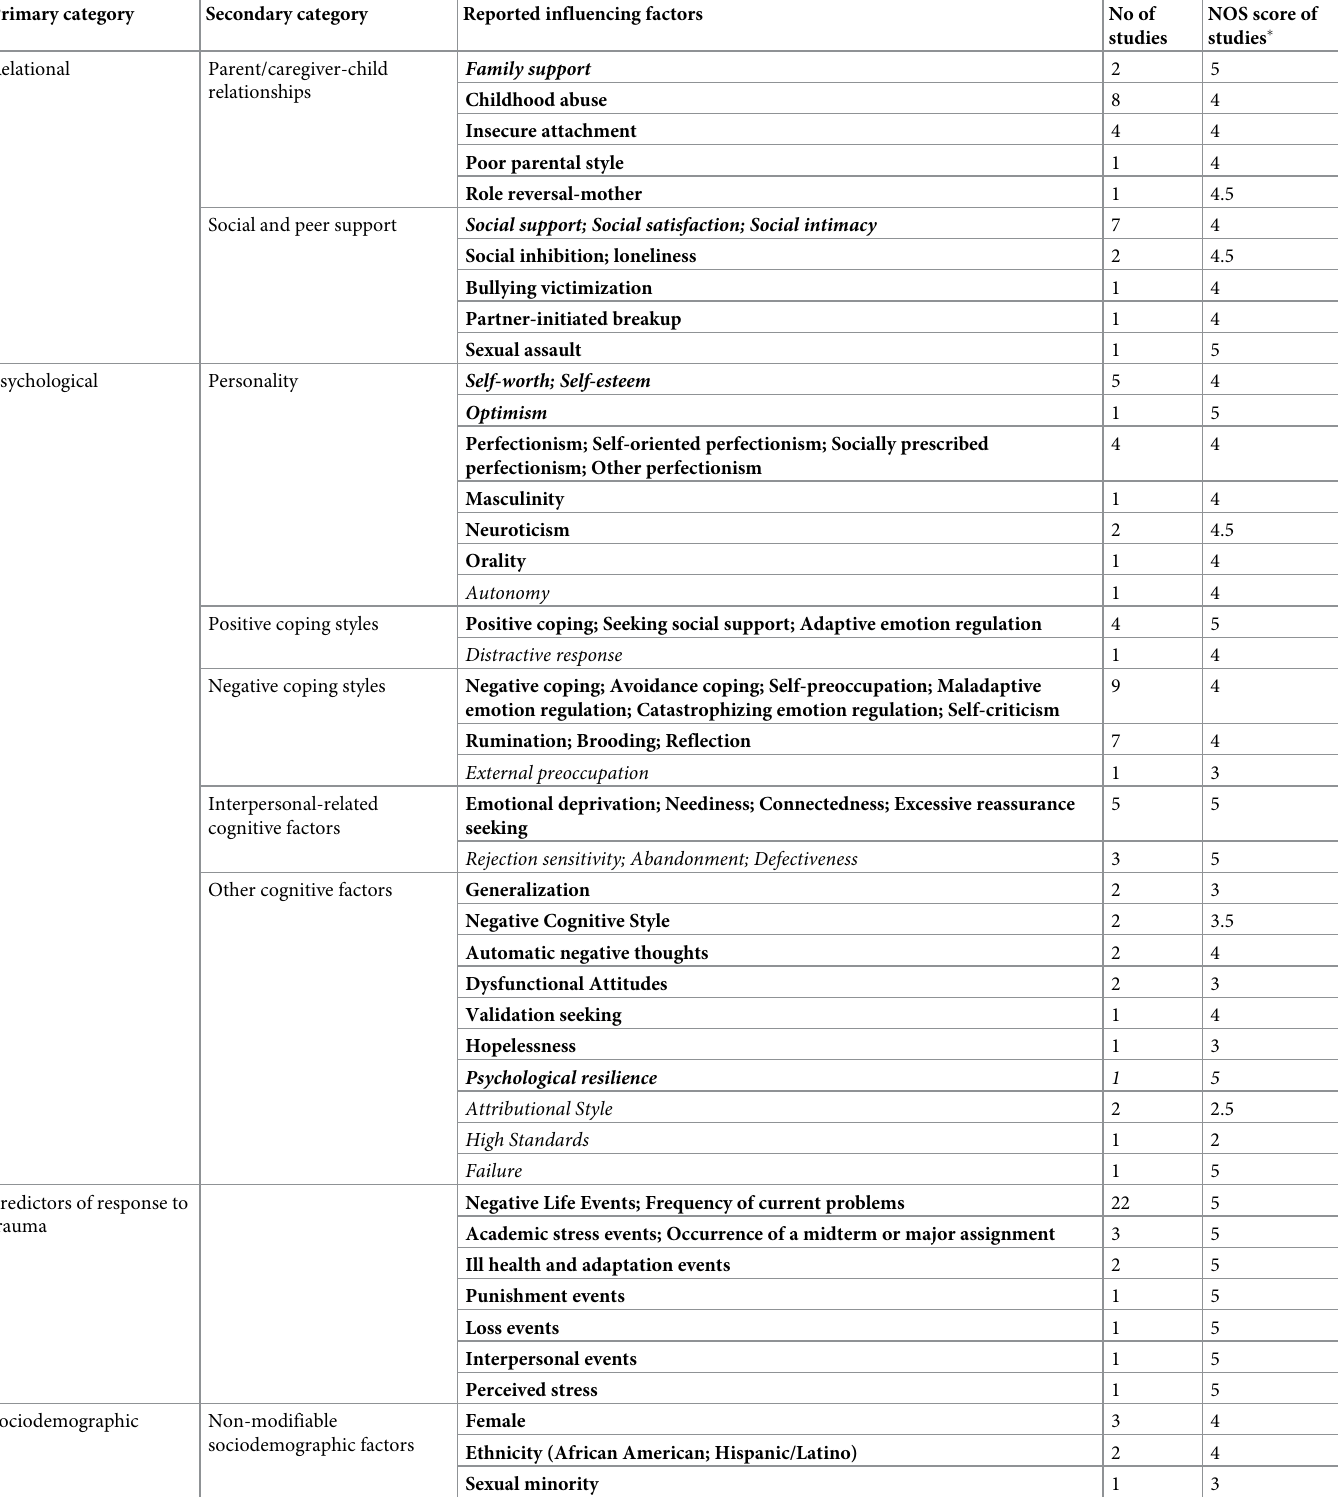
Table 2. Influencing factors of depressive symptoms in 73